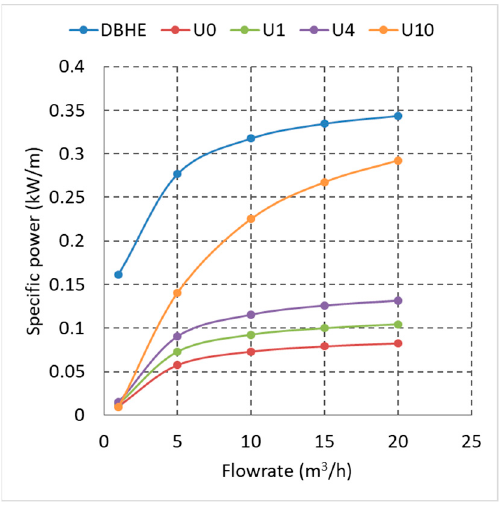
Figure 14. Specific power vs flow rate (after six months of startup).